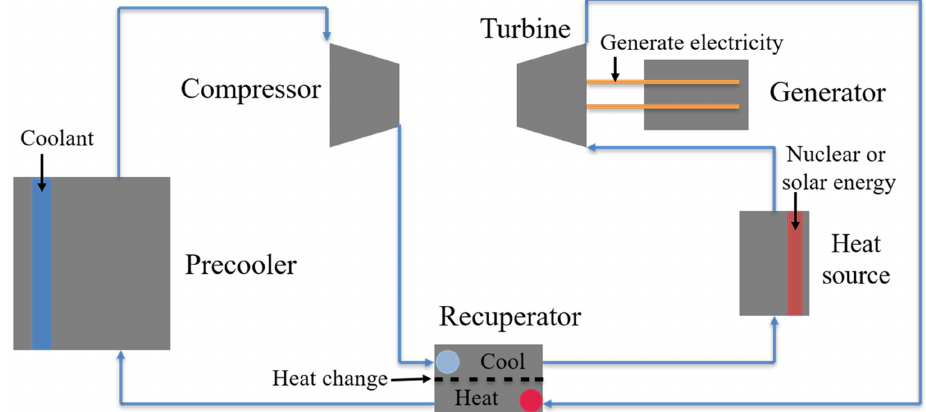
Figure 3. A simple schematic of the closed Brayton cycle system.